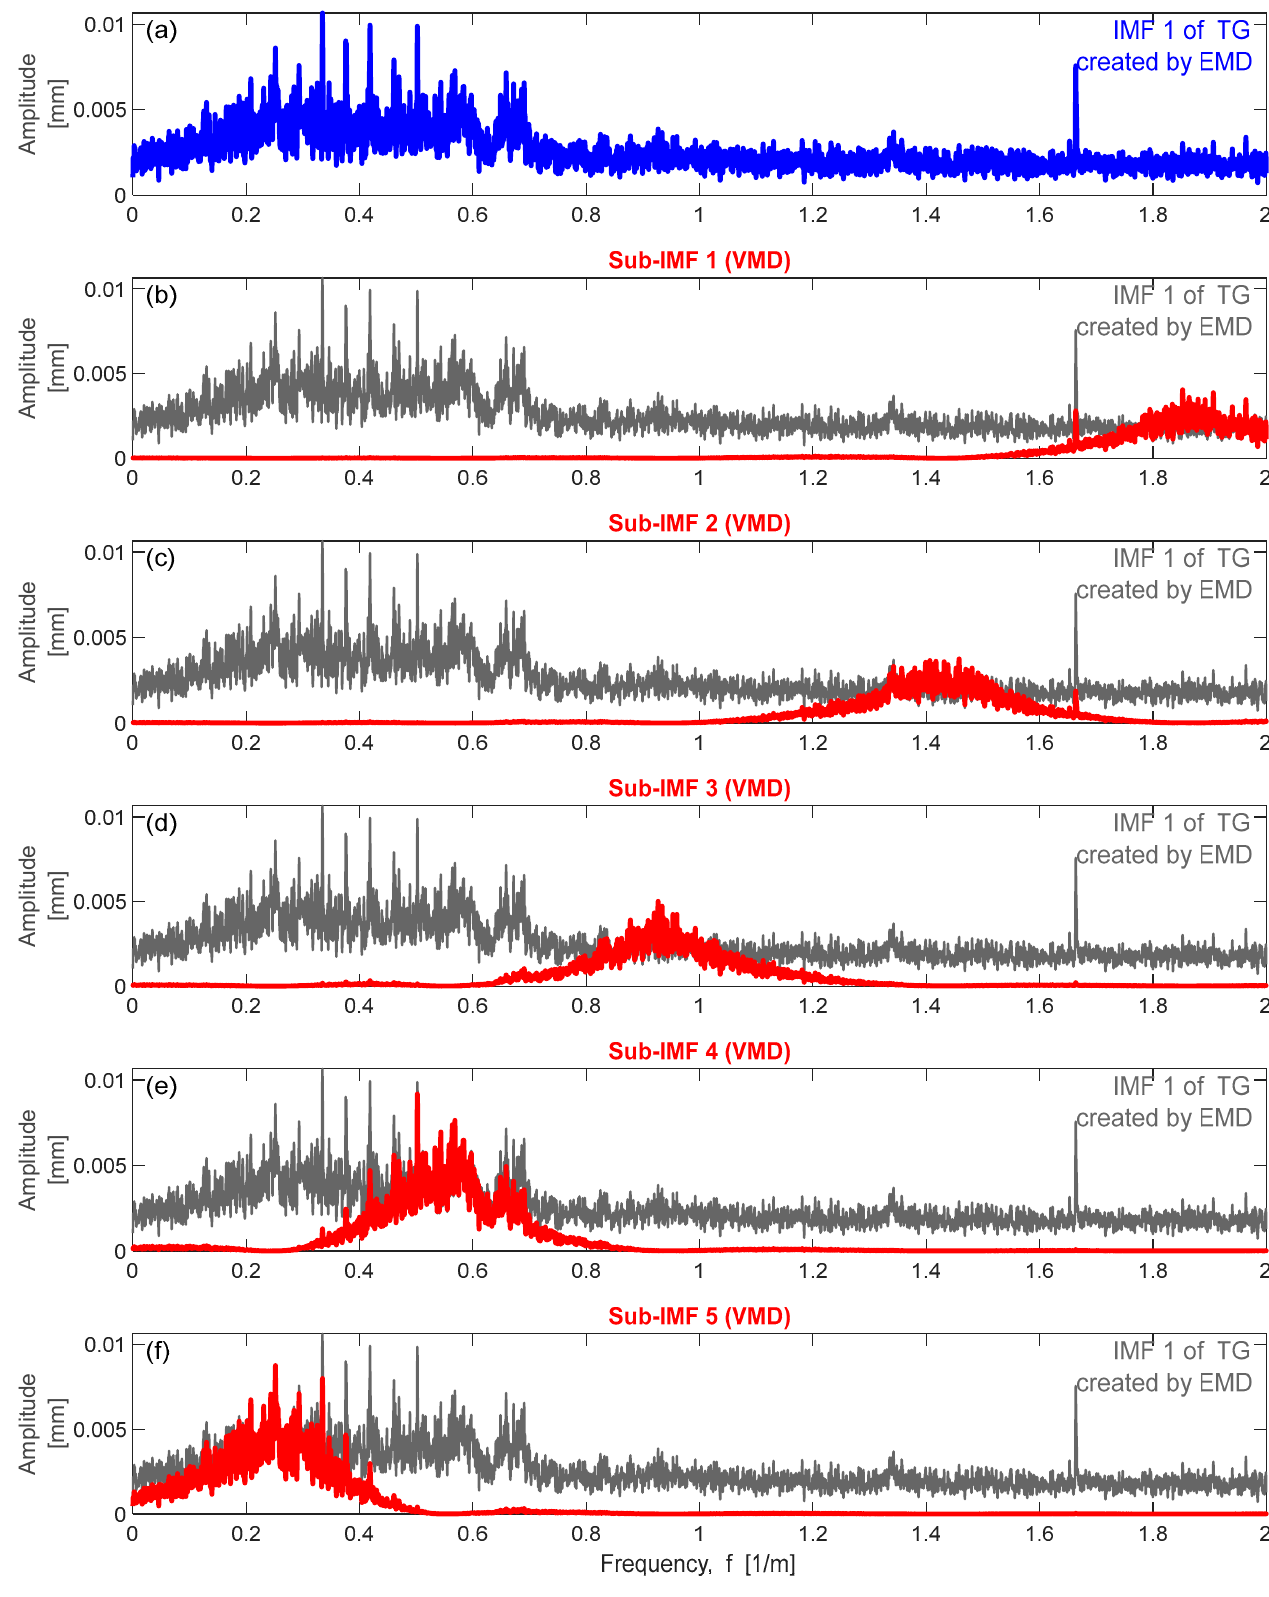
Figure 12. VMD’s spectral decomposition of the first IMF extracted from TG using EMD indicates the in- herent sub-IMF components (track section No. 4). ( a ) IMF 1 of TG created by EMD; ( b ) Sub-IMF 1; ( c ) Sub- IMF 2; ( d ) Sub-IMF 3; ( e ) Sub-IMF 4 and ( f ) Sub-IMF 5.4.2.3. Variational Mode Decomposition